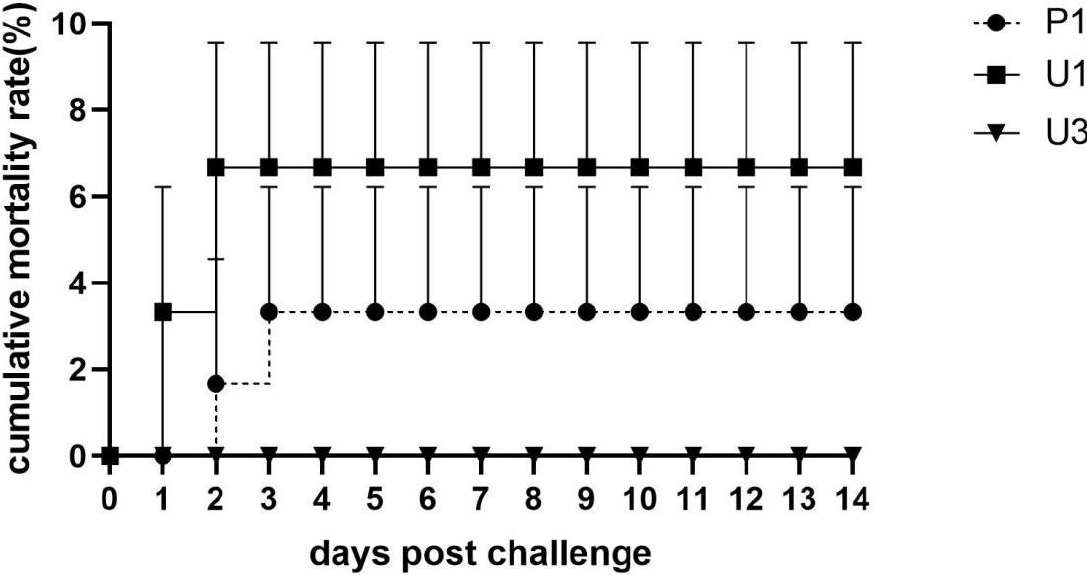
Figure 4. Cumulative mortality rate of largemouth bass in the P1, U1, and U3 groups infected with MSRV.